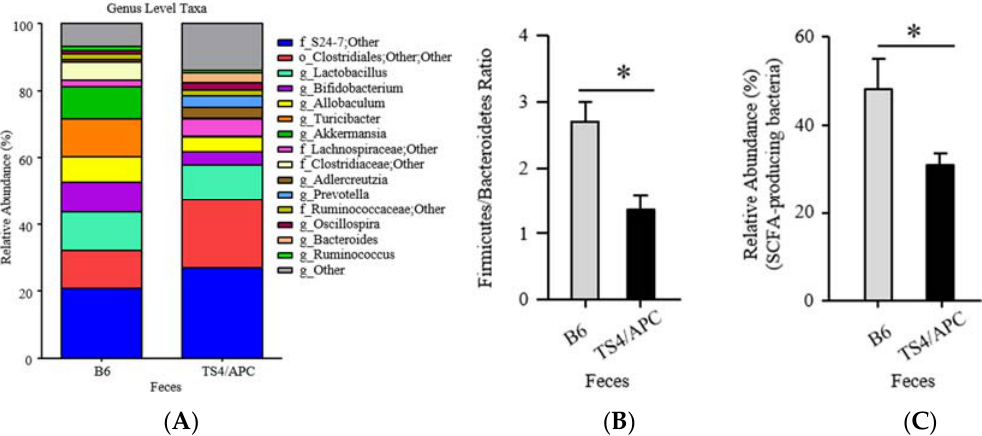
Figure 2. ( A–C ) Significantly different microbial profiles between TS4/APC and B6 chow-fed mice feces: ( A ) Stacked histograms depicting 90% of the rarefied sequences of microbial taxa (relative abundance percentages of total bacteria at the genus) between mice groups; ( B ) Firmicutes-to-Bacteroidetes ratio and; ( C ) Short-chain-fatty-acid (SCFA) bacterial taxa both significantly lower in TS4/APC chow-fed mice.